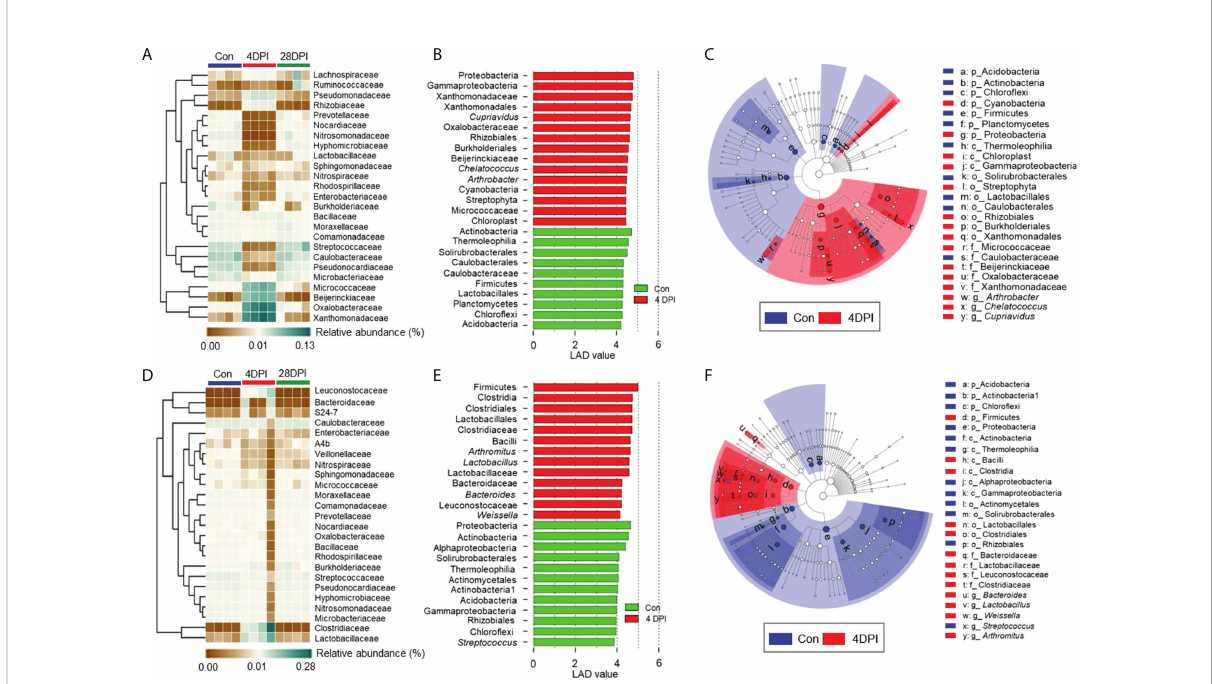
FIGURE 5 Differential bacterial taxa between the control and 4 DPI groups in GM and bile. Heat map showing the hierarchical clustering results for the abundance of top 25 bacterial family in the GM (A) and bile (D) from control fi sh and trout infected with IHNV at 4 and 28 DPI ( n = 8 fi sh per group). Each column represents one sample. Bar chart of the log-transformed LDA score of bacterial taxa found to be signi fi cantly associated with control fi sh and trout infected with IHNV at 4 DPI in GM (B) and bile (E) by LEfSe ( p < 0.05) ( n = 8 fi sh per group). Cladogram representation of LDA analysis in B and E showing the phylogenetic relationships among the bacterial taxa found to be signi fi cantly associated with control fi sh and trout infected with IHNV at 4 DPI in GM (C) and bile (F) by LEfSe ( p < 0.05) ( n = 8 fi sh per group). Data are representative of two independent